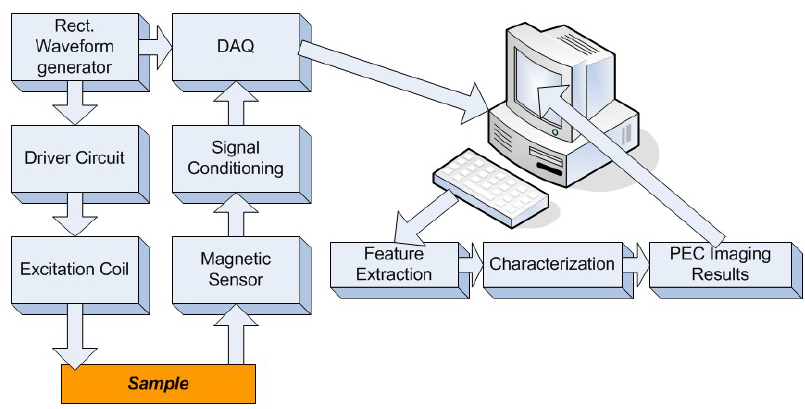
Figure 18. Block diagram of PEC imaging system.